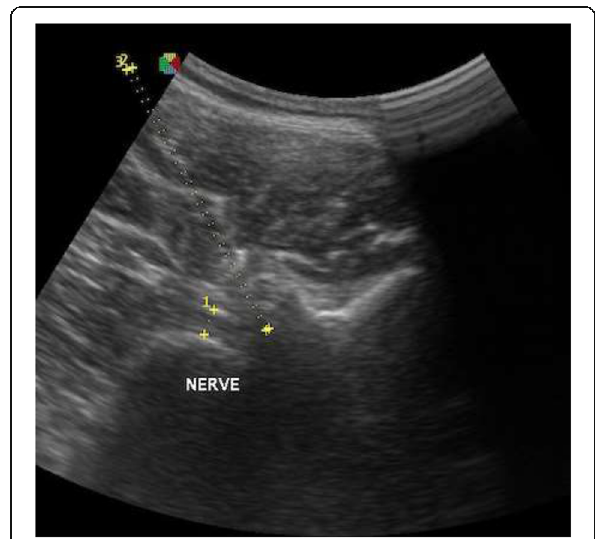
Fig. 8 Transverse axial oblique sonogram of lumbar vertebra shows nerve root and needle direction (yellow dots) towards DRG in front and medial to lateral border of inferior articular process